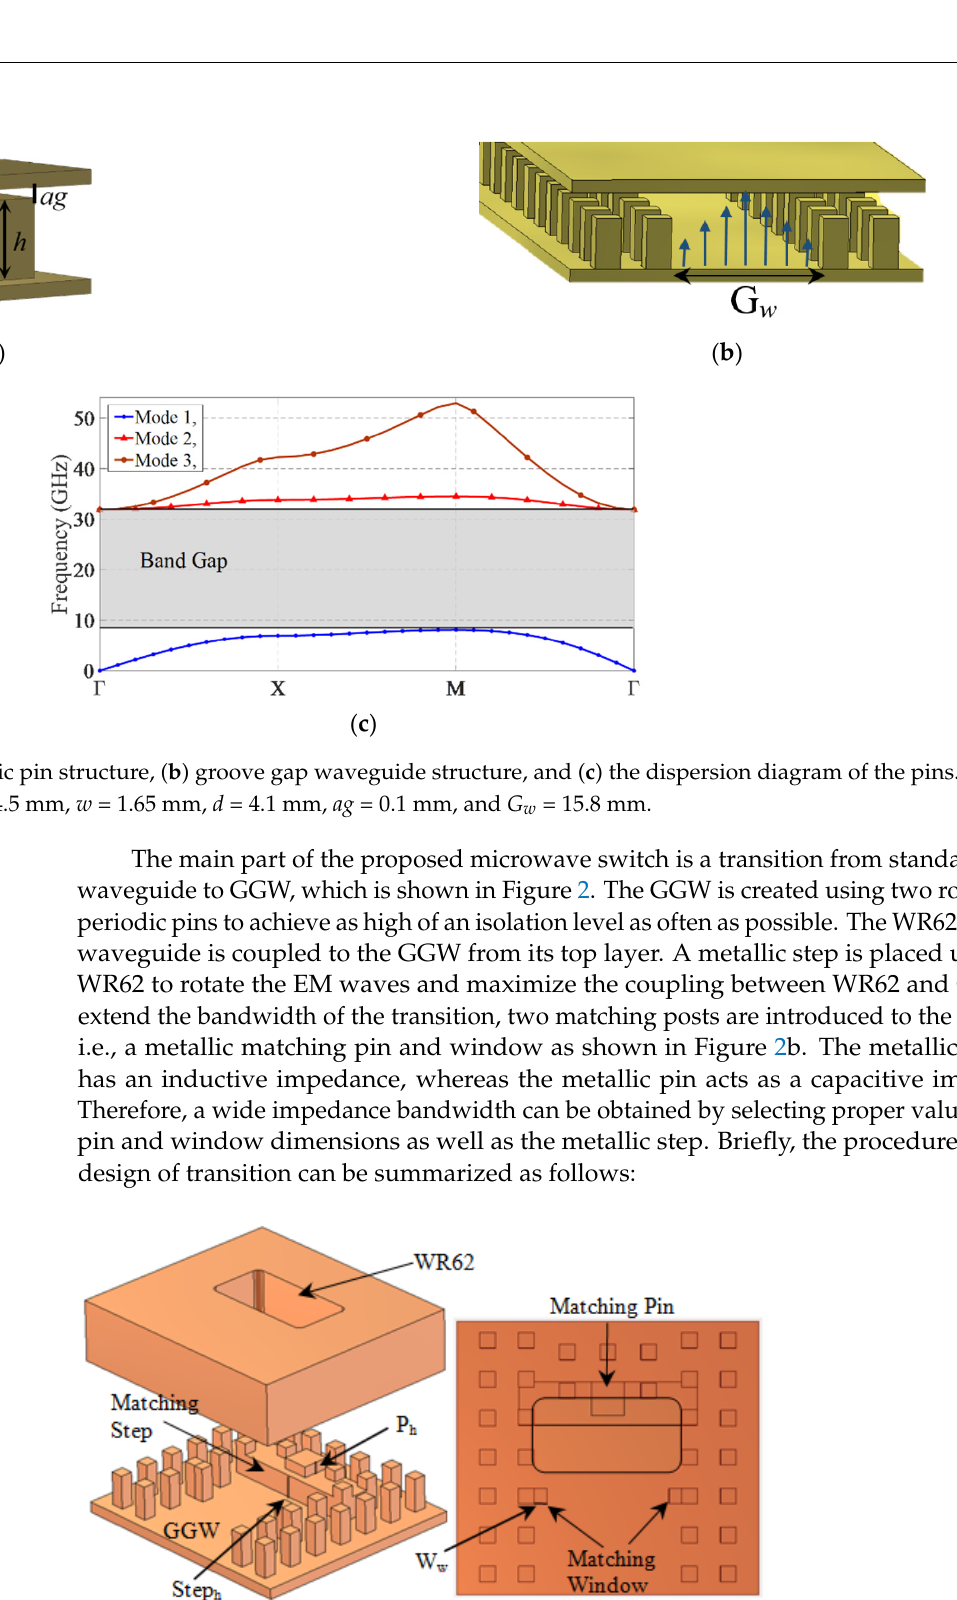
Figure 2. ( a ) Exploded view and ( b ) top view of the WR62 to GGW transition structure. The parameters are step height (Step h = 3 mm), step width (Step w = 4.5 mm), pin height (P h = 1.5 mm), pin width (P w = 3.5 mm), and window width (W w = 1.3 mm).